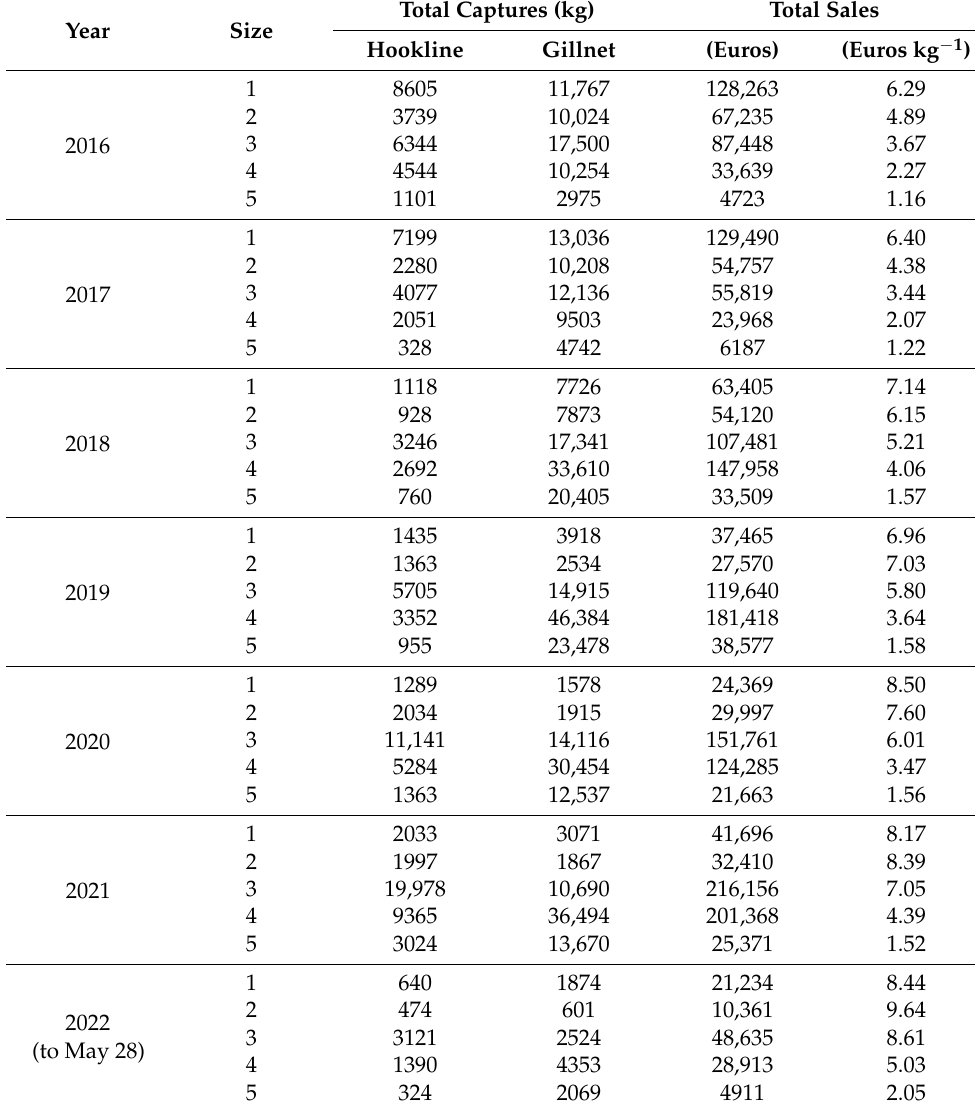
Table 3. Total landings and selling prices of P. mediterraneus captured by hookline and gillnet by the artisanal fleet of Conil (south of Spain) from 2016 to May 2022. It is observed that the price increases with fish size, and that price varies over the